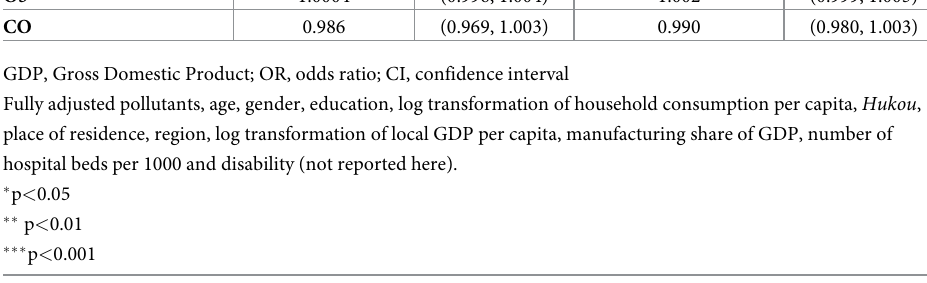
GDP, Gross Domestic Product; OR, odds ratio; CI, confidence interval Fully adjusted pollutants, age, gender, education, log transformation of household consumption per capita, Hukou , place of residence, region, log transformation of local GDP per capita, manufacturing share of GDP, number of hospital beds per 1000 and disability (not reported here).